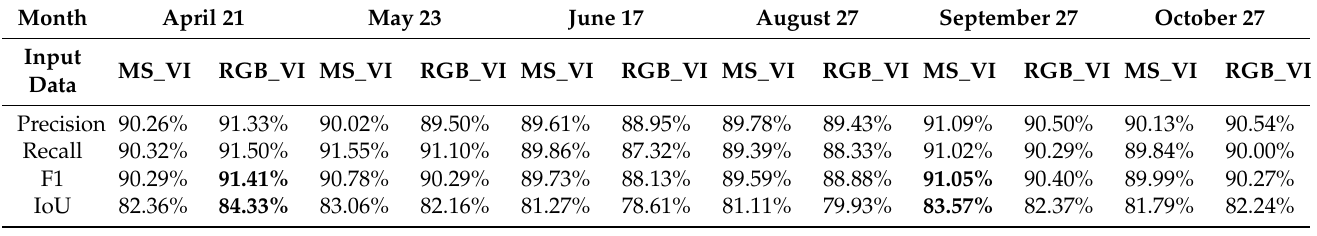
Table 5. Accuracy of the model with added vegetation indices (VIs) in different months. For MS and RGB imagery, the highest IoU and F1 are highlighted in bold.